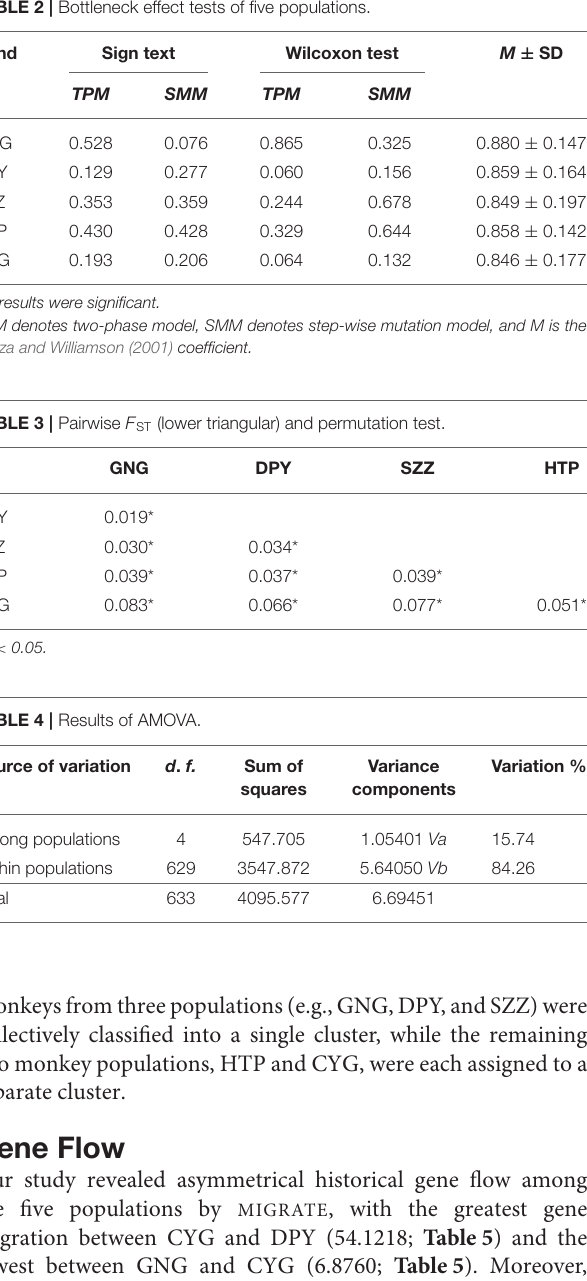
TABLE 2 | Bottleneck effect tests of five populations.